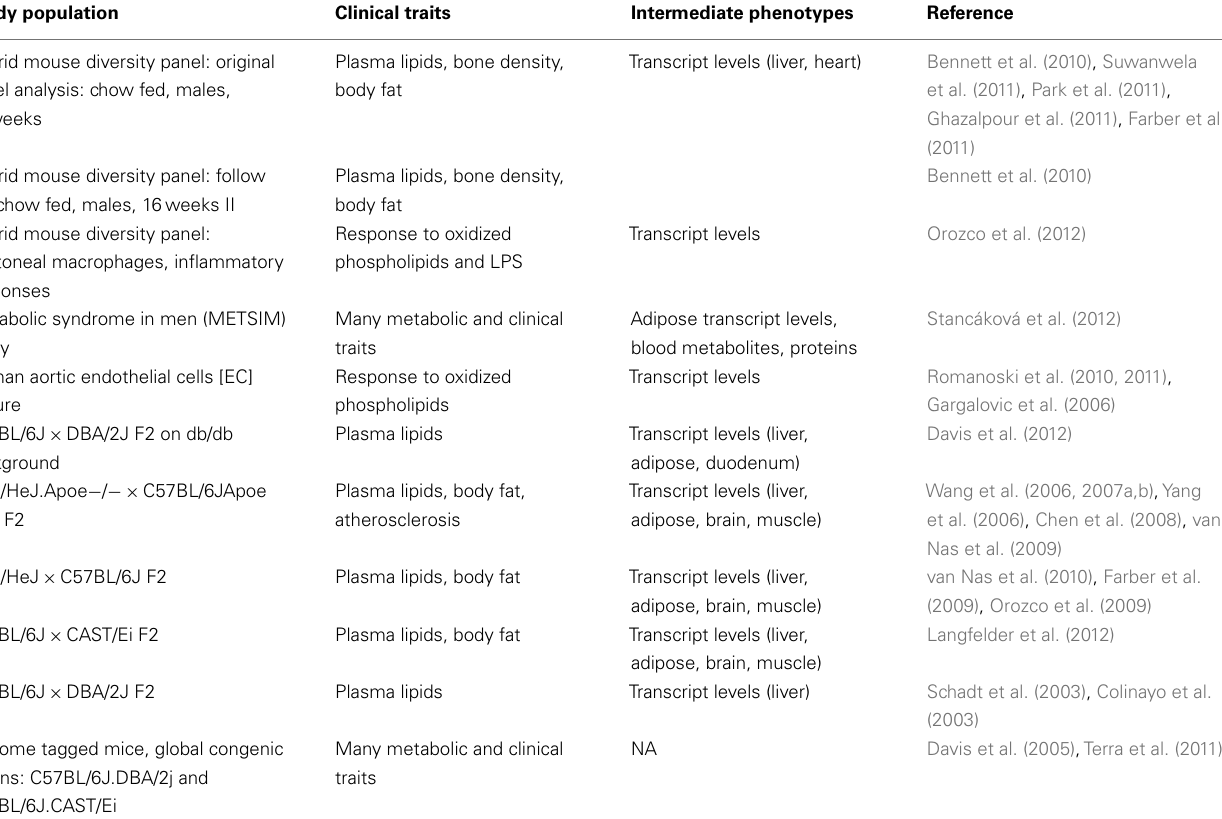
Table 1 | Data sets contained in the systems genetics resource.